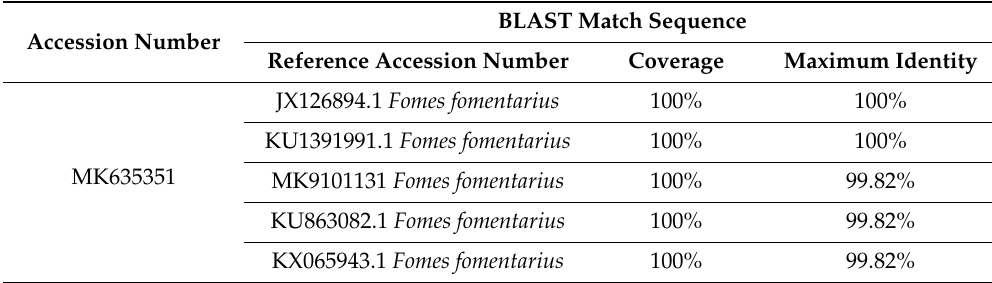
Table 1. Gene Bank accession numbers and top BLAST match sequences of the mushroom isolates along with maximum identity and query coverage.